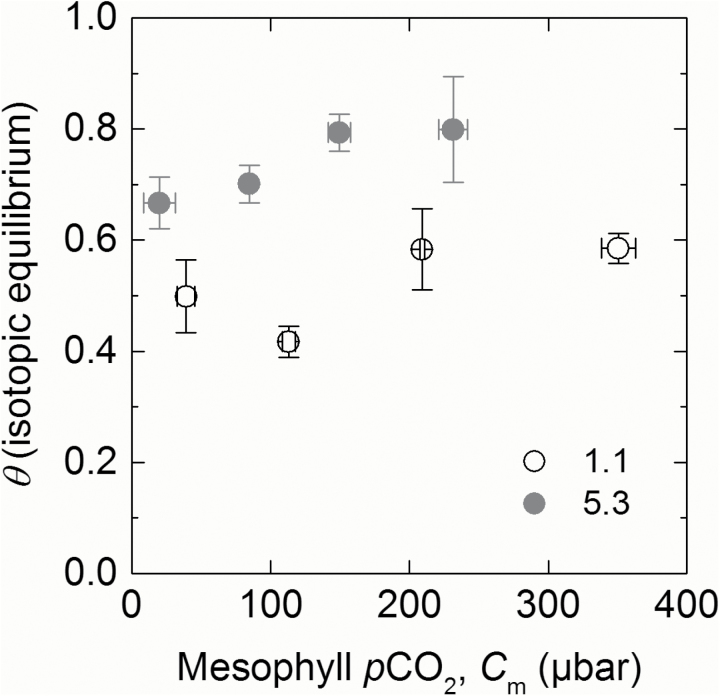
Average isotopic equilibrium (theta, θ) over a range of mesophyll pCO2 in two reduced CA lines 5.3 (grey) and 1.1 (white). Measured values of θ were determined from Δ18O using Equation 16. Each point represents the average measurement of three T2 plants.